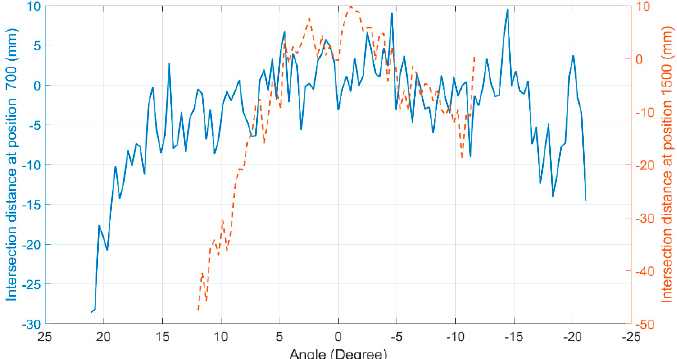
those of the Sensor Simulator (hybrid model) are marked with “x” [29].